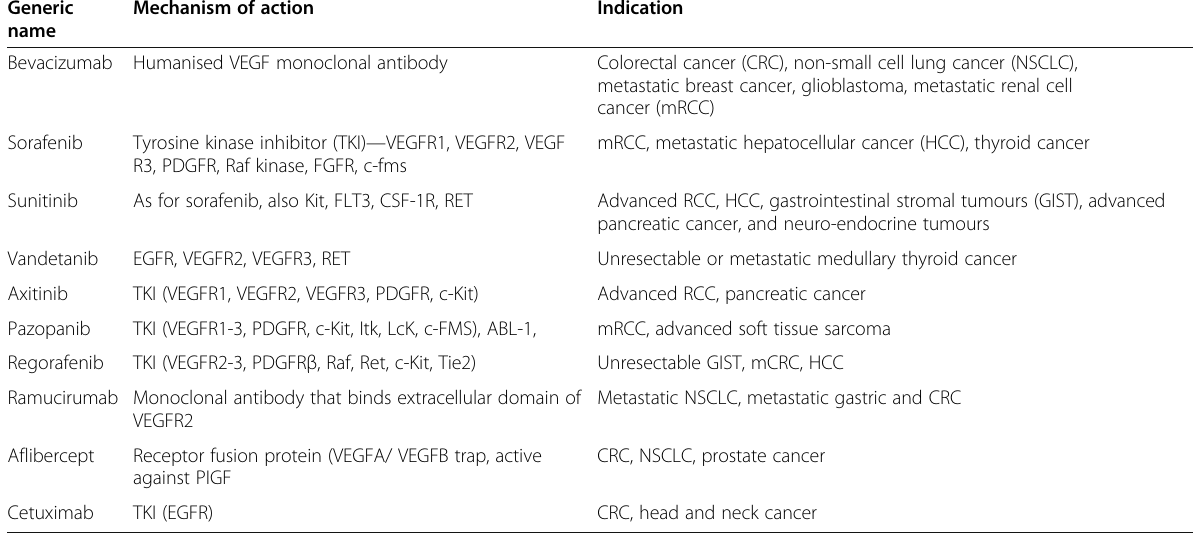
Table 1 Selected VEGF-targeted anti-angiogenics and their therapeutic indications Generic Mechanism of action name